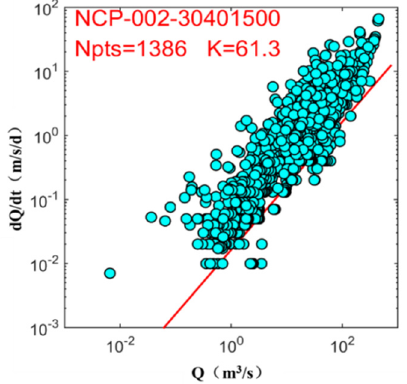
Figure 2. Estimation of the recession constant (plot of log ( dQ / dt ) and log ( Q ) for the Taoer River basin) using the Automatic Baseflow Identification Technique (ABIT). The red line denotes the lower 5% envelope with a slope of 0.984, while the estimate of the characteristic drainage time scale was κ = 61.3 days.